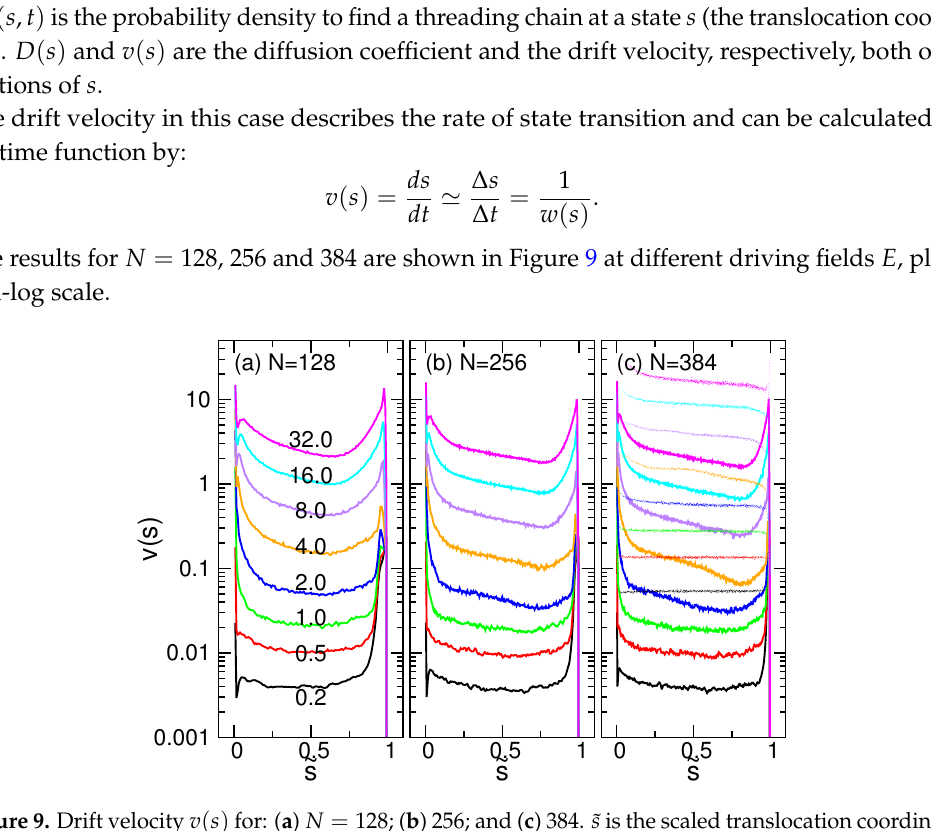
Figure 9. Drift velocity v ( s ) for: ( a ) N = 128; ( b ) 256; and ( c ) 384. ˜ s is the scaled translocation coordinate. The strength of the driving field E is indicated near the curve. In panel (c), the estimated drift velocity v es ( s ) is plotted in thin dashed curves in the same color